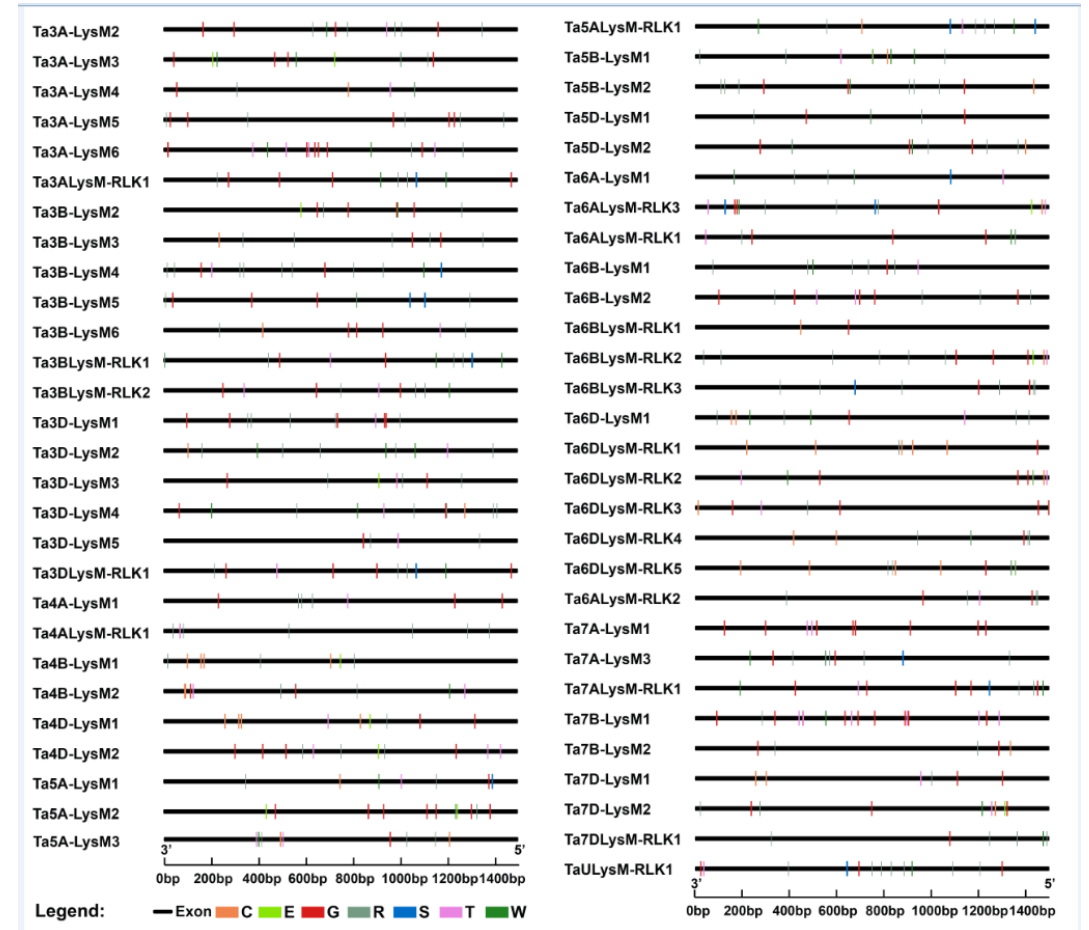
Figure 7. Cis-element analysis of the LysM gene family. Different colors and capital letters represent different cis-elements. G: GT1CONSENSUS, W: WBOXATNPR1, R: WRKY71OS, C: GCCCORE, T: GT1GMSCAM4, S: SEBFCONSSTPR10A, E: ELRECOREPCRP1.